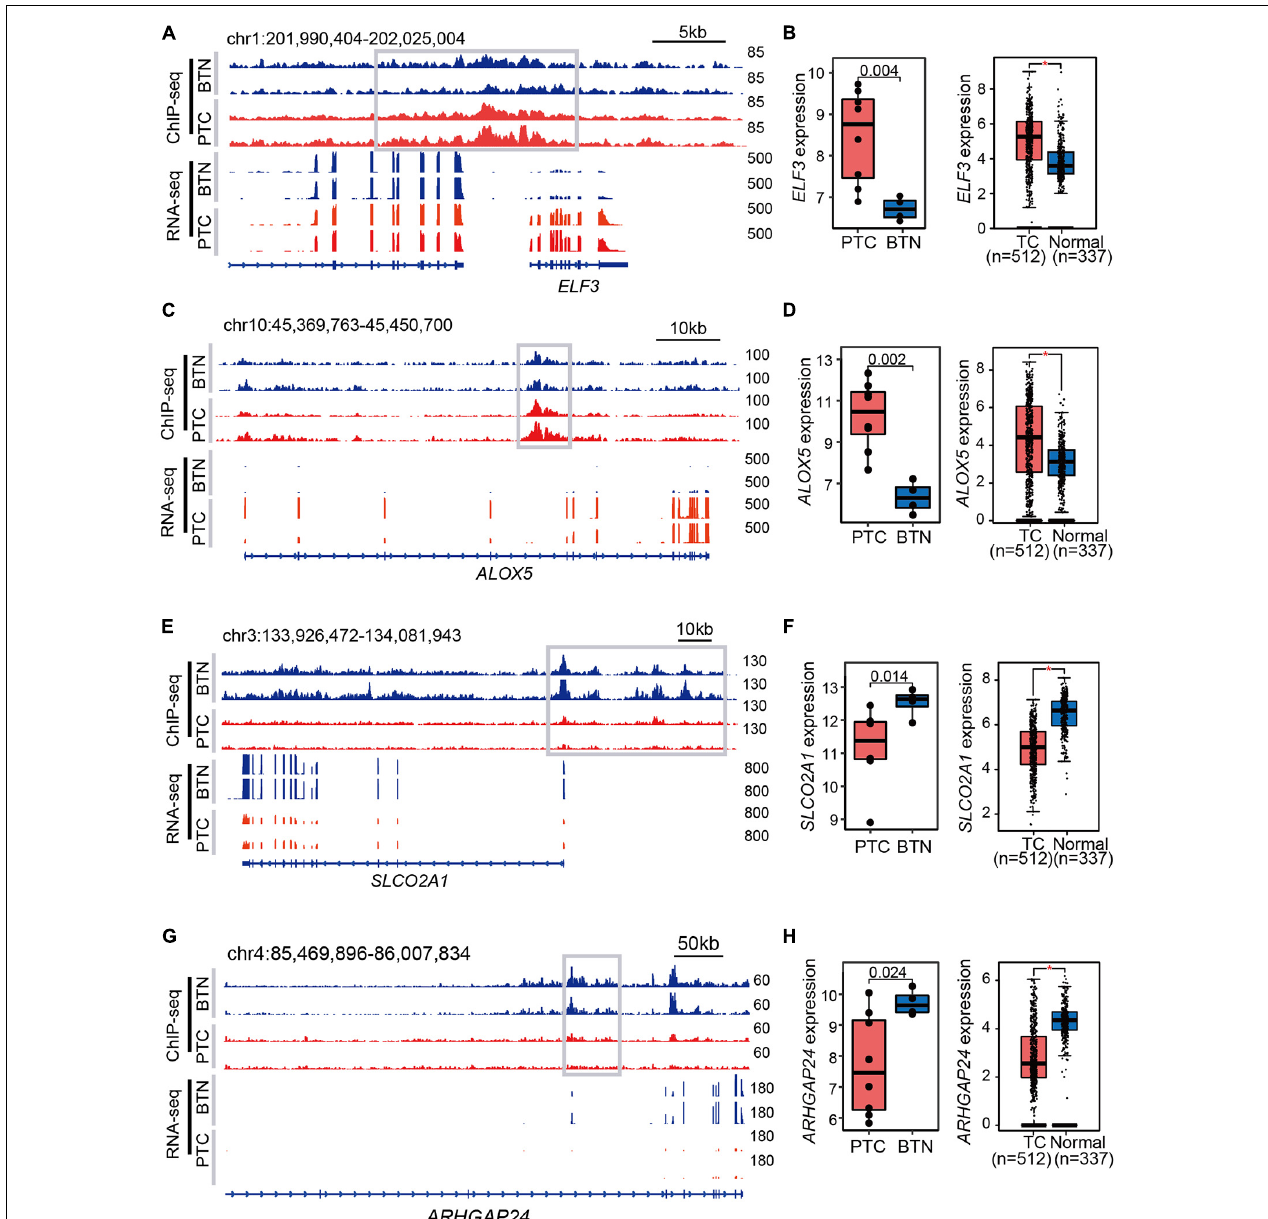
FIGURE 4 | Examples of histotype-specific SE-associated genes. (A,C) Gene tracks of PTC-specific SEs. The adjacent genes ELF3 and ALOX5 showed strong SE peaks and RNA-seq signals in PTC tissues. (B,D) Expression profiles in PTC-specific SEs. Relative expression levels between PTC and BTN are shown in the left panel, while the right box plots indicate expression analysis of TC and normal samples from TCGA and GTEx datasets. (E,G) BTN-specific SE tracks and RNA-seq signals. (F,H) High expression levels of SLCO2A1 and ARHGAP24 in BTN tissues, and similar trends were observed in TCGA and GTEx databases. * p < 0.05. SE, super-enhancer; PTC, papillary thyroid carcinoma; BTN, benign thyroid nodule; TCGA, The Cancer Genome Atlas; GTEx, Genotype-Tissue